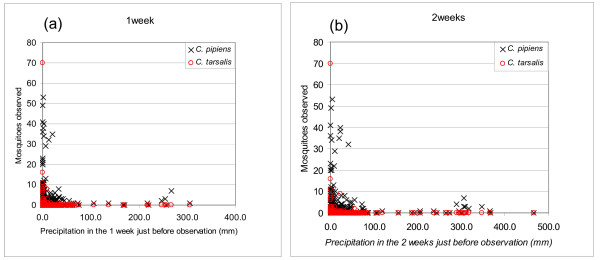
Relation between rainfall and mosquito abundance. (a) Against rainfall for 1 week prior to observation and, (b) Against rainfall for 2 weeks prior to observation